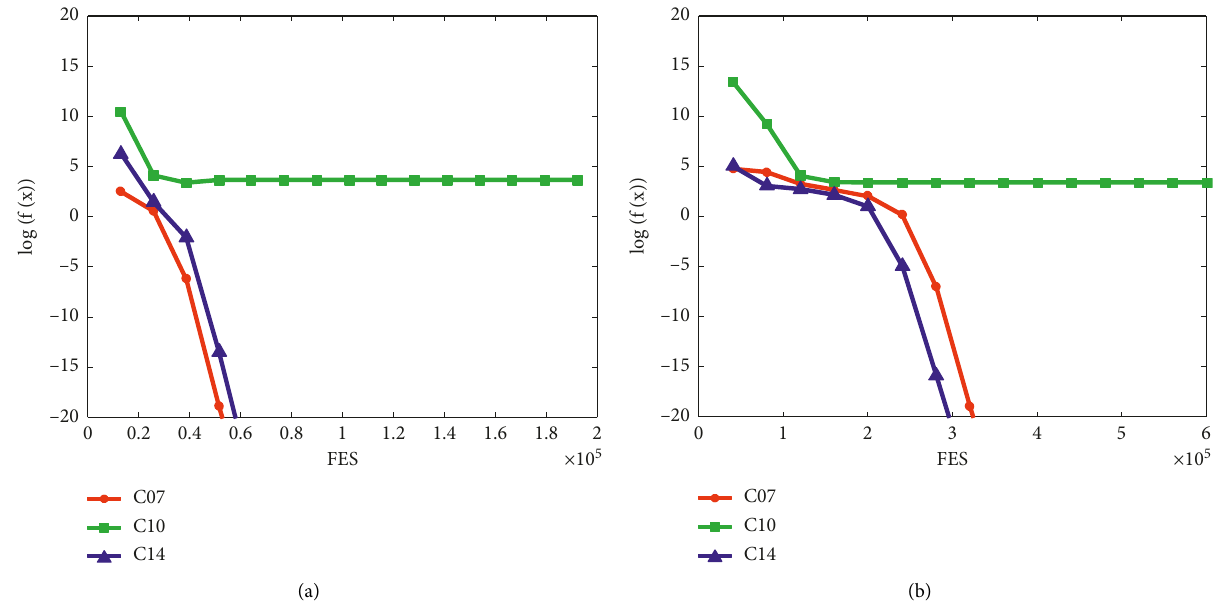
Figure 3: Convergence graphs of HyCO on six representative COPs from IEEE CE C2010. (a) C07, C10, and C14 with 10d. (b) C07, C10, and C14 with